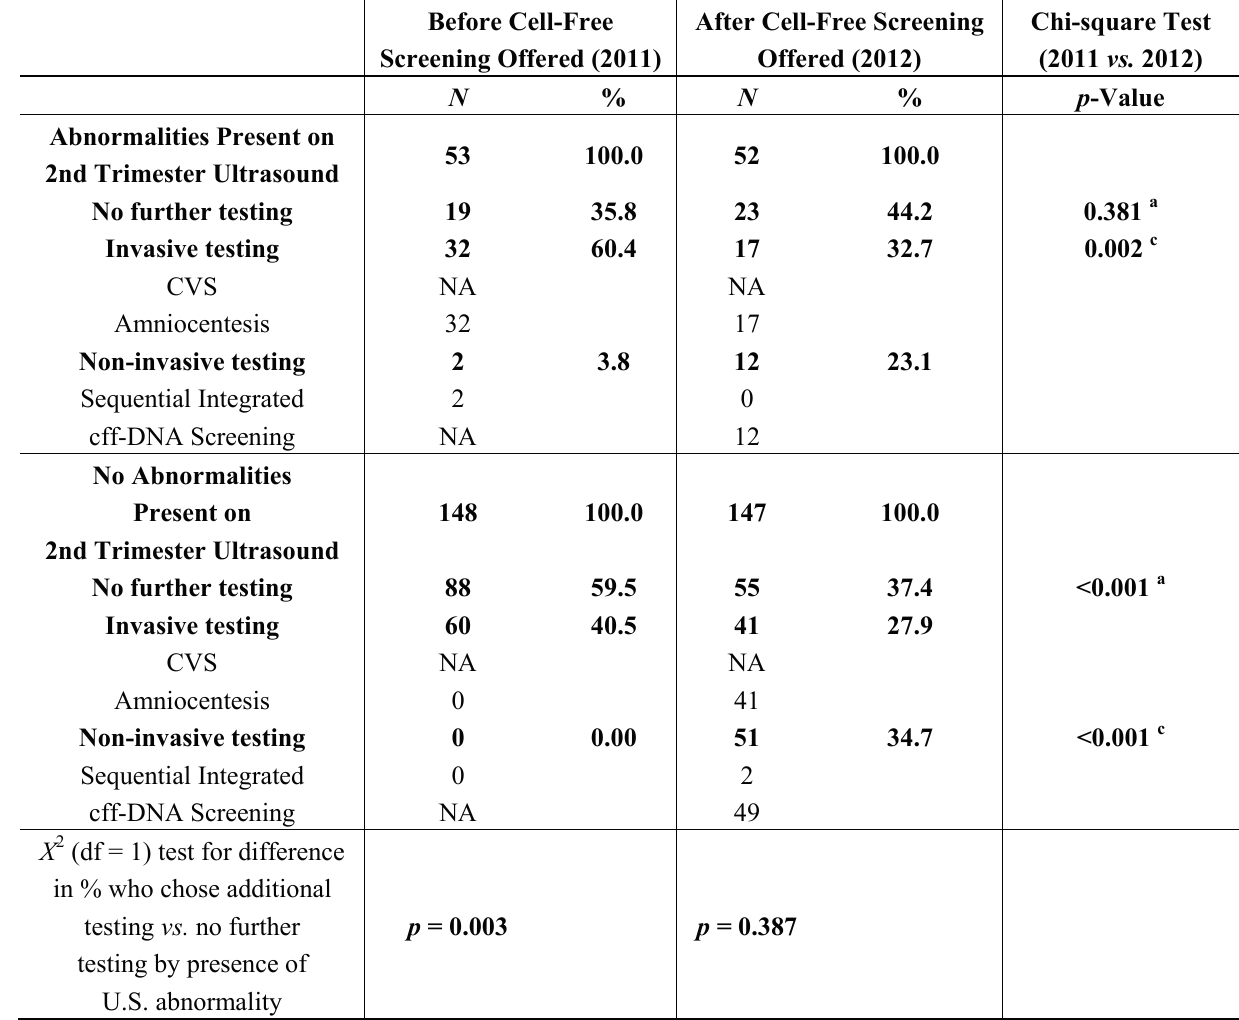
Sequential Integrated 0